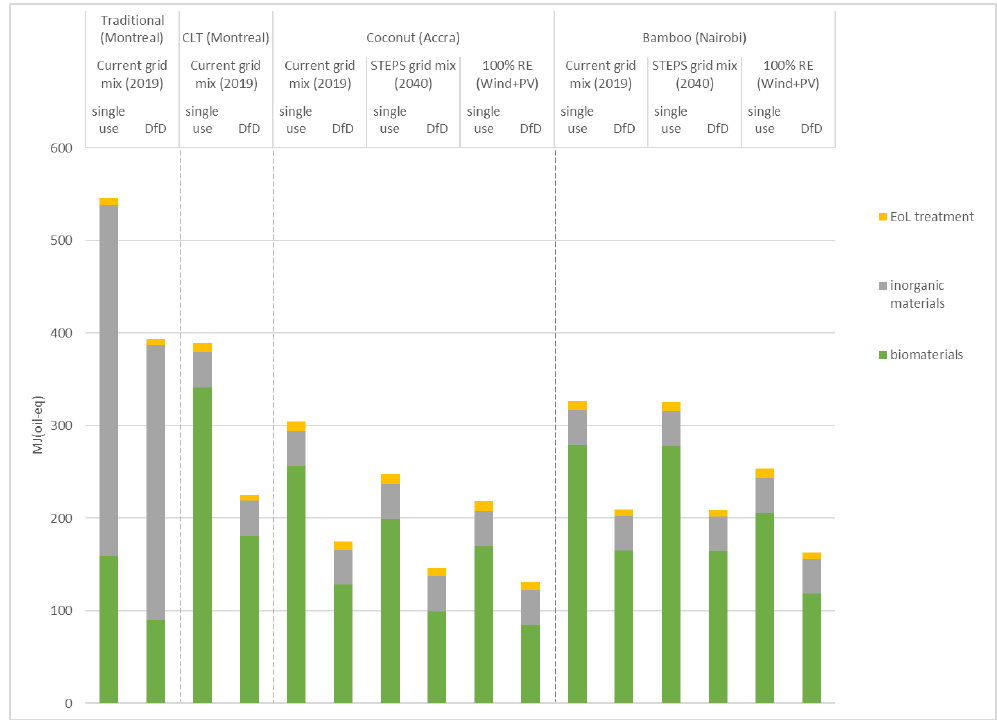
Figure 6. Nonrenewable cumulative energy demand results for the four wall assemblies and locations, with sensitivity analyses (FU = 1 m 2 ).